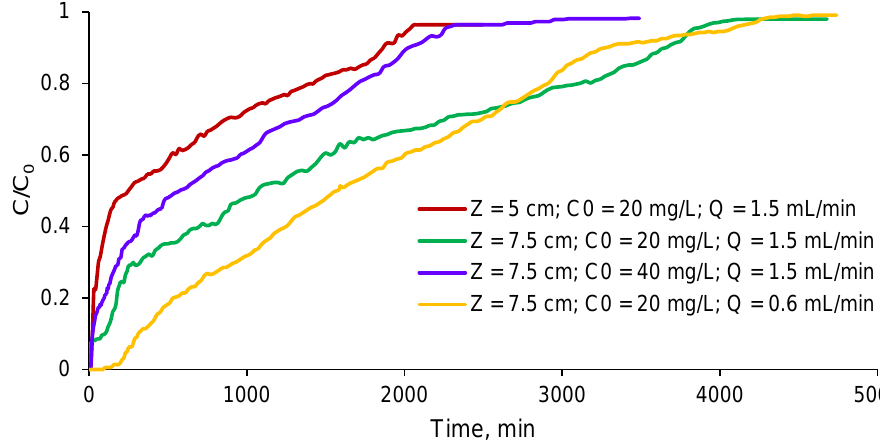
Figure 4. Effect of working parameters on the breakthrough for ethacridine lactate biosorption onto SPRBA 5% biosorbent.